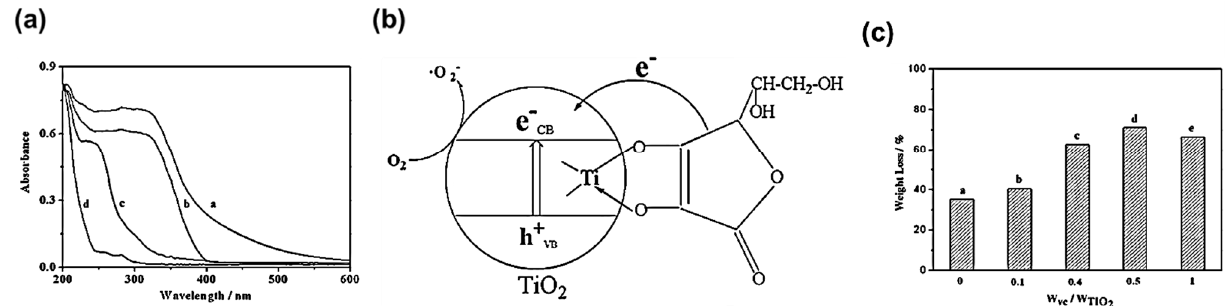
Figure 10. Photodegradation of PVC–TiO 2 film. ( a ) UV–VIS absorption spectra of the PVC–TiO 2 composite films with varying TiO 2 contents. Inset: Chemical formula of PVC. ( b ) Apparent absorbance of the composite films at λ = 350 nm as a function of the film thickness. ( c ) Weight loss of the pure PVC and PVC-TiO 2 (1.5 wt%) composite film during irradiation in air (filled symbols) or N 2 (open symbols) atmosphere [60]; reprinted from [60] with permission from Elsevier.